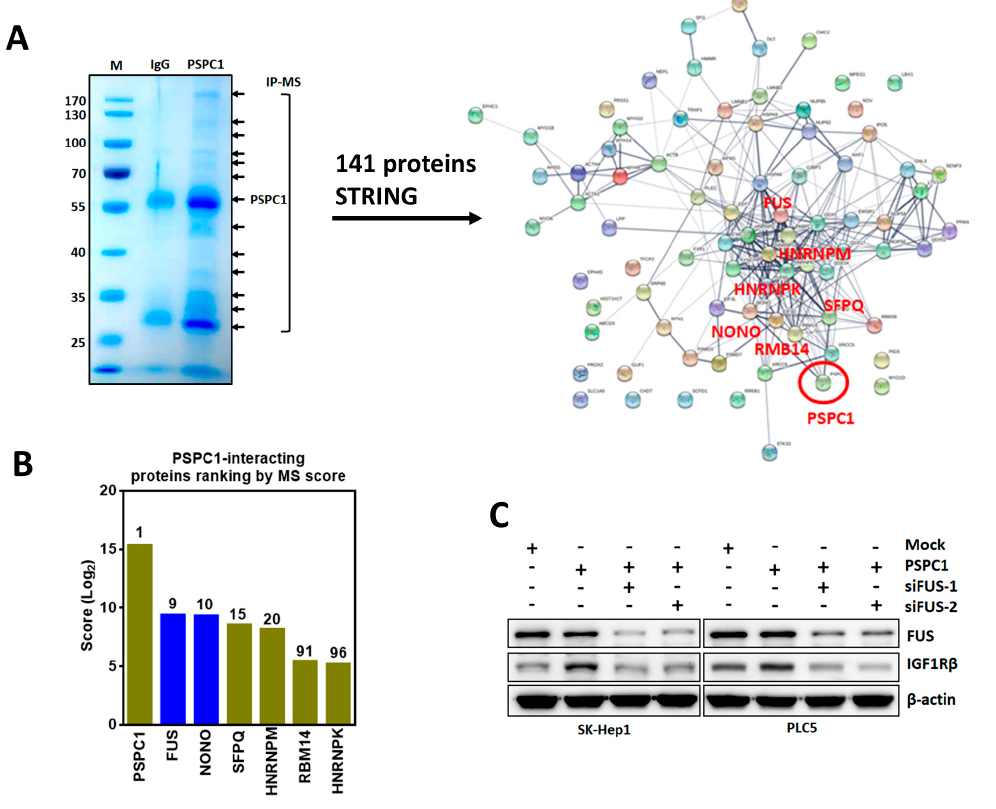
Figure 6. Paraspeckle core components PSPC1, FUS, NONO, and lncRNA Neat1 are essential for IGF1R induction. ( A ) Total cell lysates of Huh7 cells were immunoprecipitated using the PSPC1 antibody and then conducted SDS-PAGE for protein separation and stained with Coomassie Blue (left panel). Bands indicated by arrows were excised for in-gel digestion and LC-MS/MS analysis. A total of 141 interacting proteins were analyzed for protein–protein interaction networks by STRING (right panel). ( B ) The ranking list of top six PSPC1-interacting proteins in descending ordered by MASS score. ( C , D ) Depletion of FUS and NONO by siRNAs in PSPC1-overexpressing SK-Hep1 and PLC5 cells cultured for 2 days following performed immunoblotting assay for detection of IGF1R expression. ( E–G ) IGF1R expression diminished by immunoblotting analysis in knockdown of FUS, NONO, or Neat1 with corresponding siRNAs in parental SK-Hep1, PLC5, Hep3B, and Huh7 cell lines cultured for 2 days. 4. Discussion